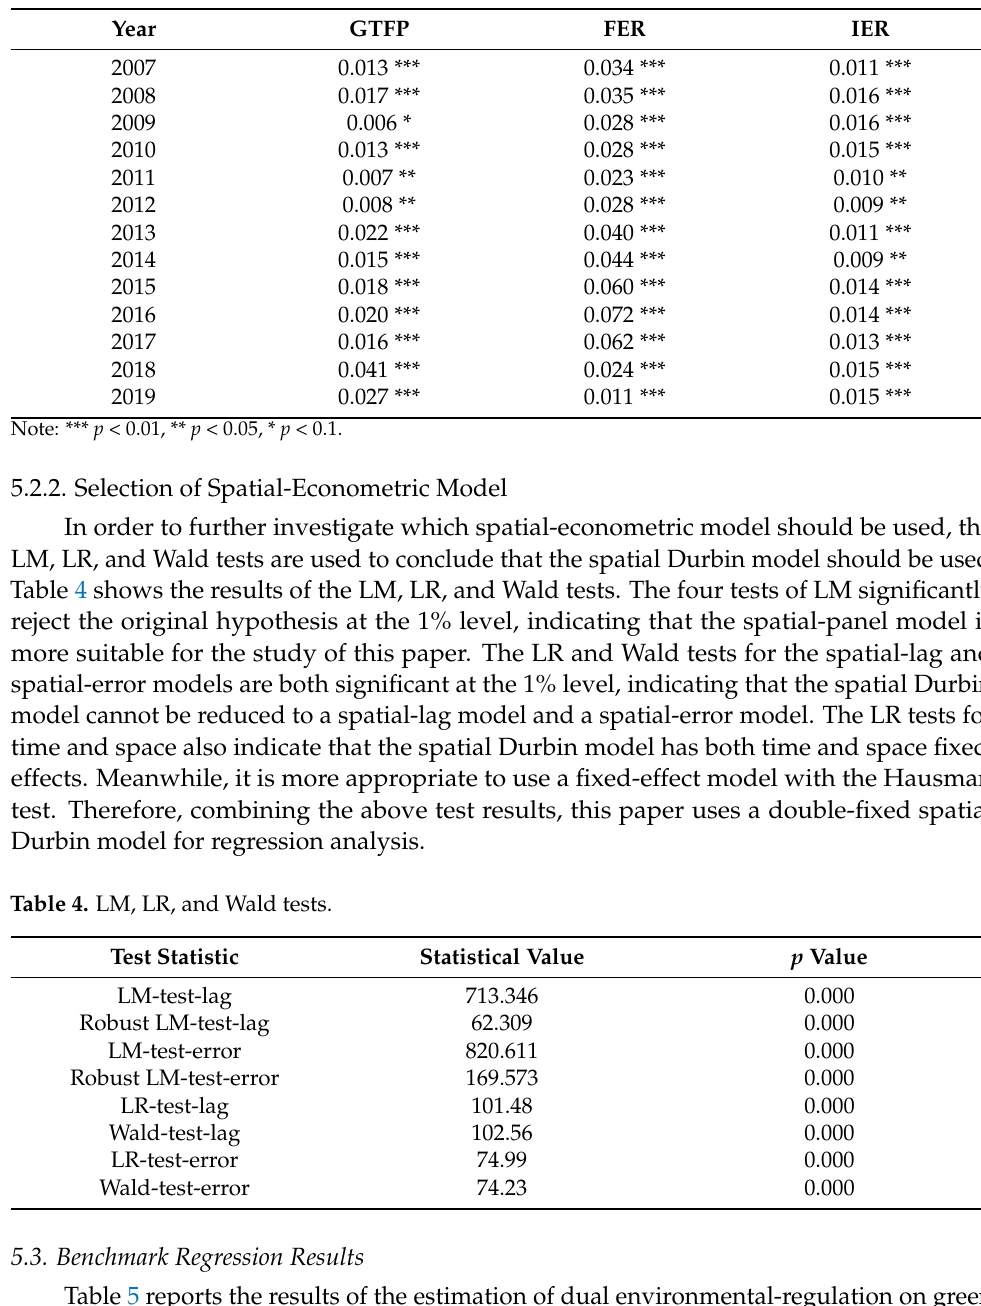
Table 3. The Global Moran’s index of main variables from 2007 to 2019.